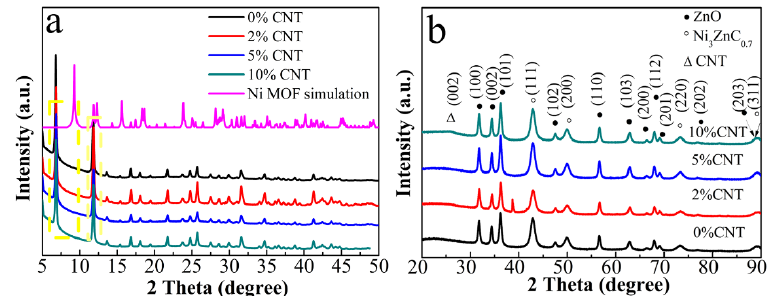
Figure 1. X-ray diffraction (XRD) patterns of ( a ) precursor of NiZn MOF; ( b ) ZnO/Ni3ZnC0.7/x% CNT (x = 0, 2, 5, 10) composites.